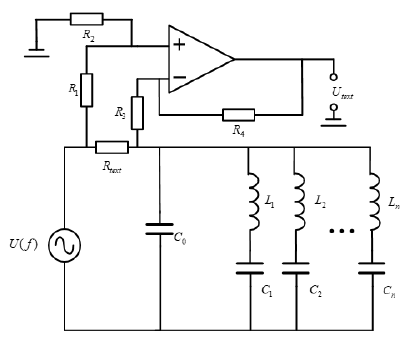
Figure 3. WPT system with detection coil array.